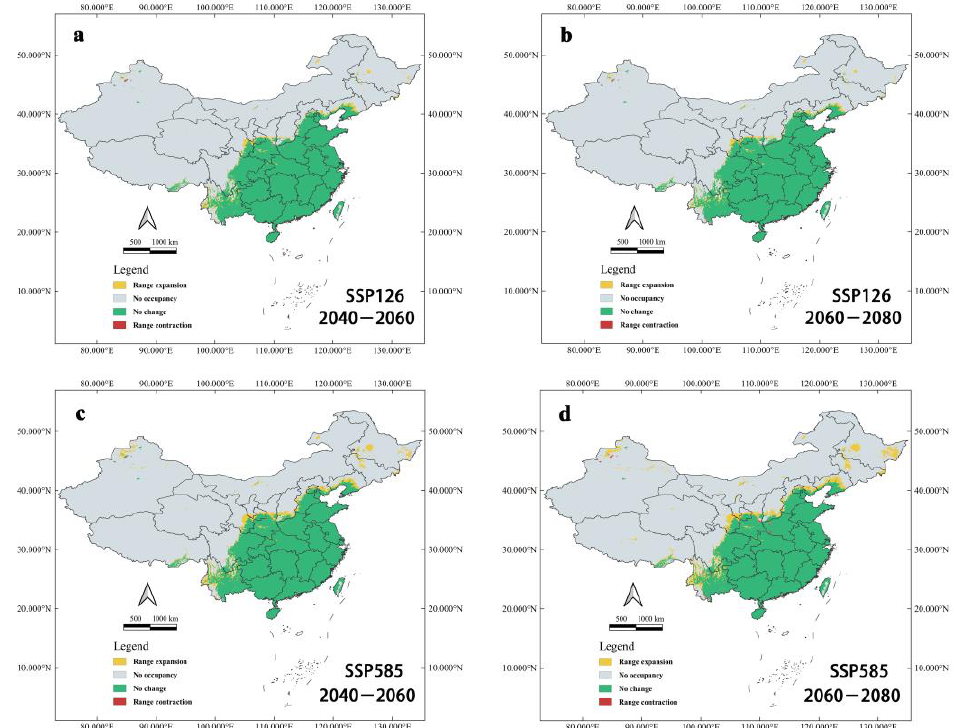
Figure 8. Changes to suitable habitats of Ar . subalbatus under future climate change predicted by the binary model. ( a ) Changes to suitable habitats of Ar . subalbatus within 2050s (2040–2060), under the SSP126 scenario; ( b ) Changes to suitable habitats of Ar . subalbatus within 2070s (2060–2080), under the SSP126 scenario; ( c ) Changes to suitable habitats of Ar . subalbatus within 2050s (2040–2060), under the SSP585 scenario; ( d ) Changes to suitable habitats of Ar . subalbatus within 2070s (2060–2080), under SSP585 scenario.